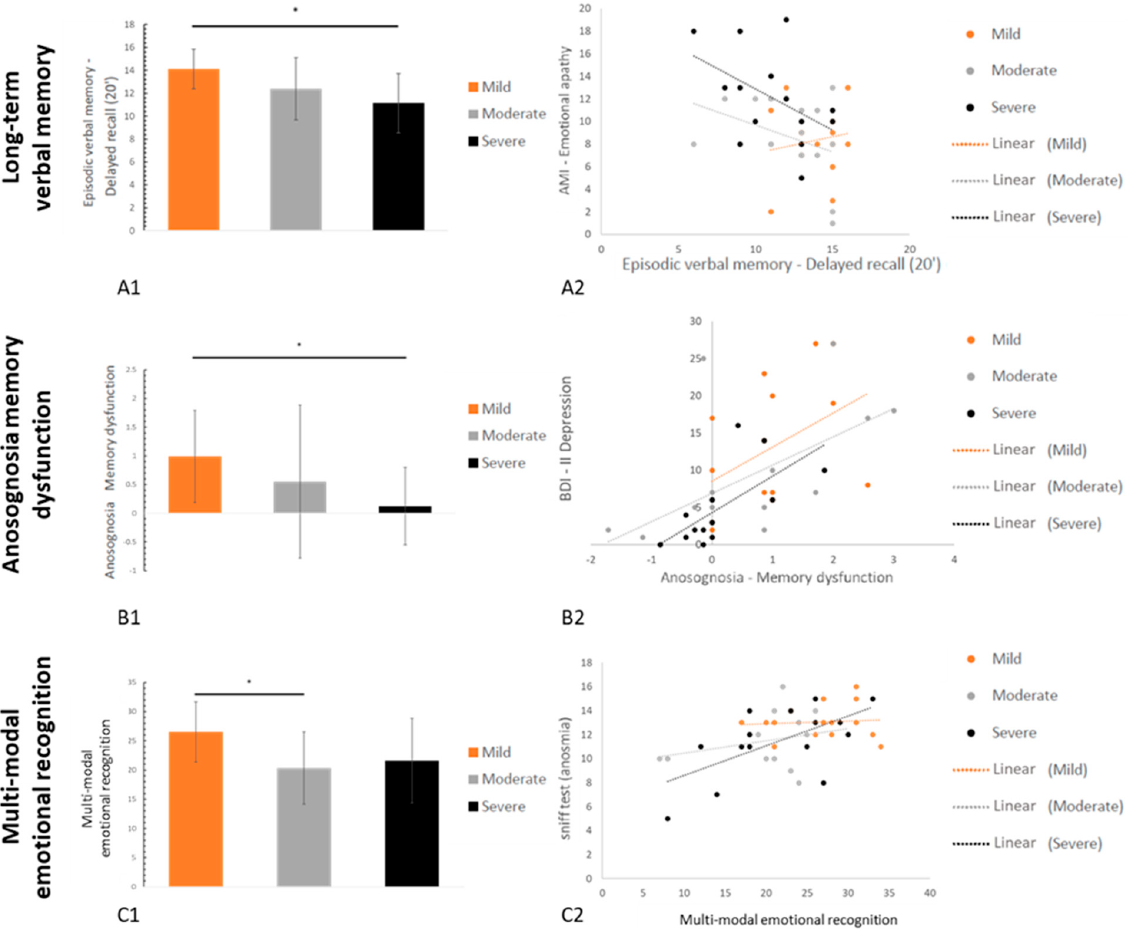
Figure 3 . Mean ratings (and standard deviations) for all three groups (severe [ICU hospitalization] in black, moderate [conventional hospitalization] in gray, and mild [no hospitalization] in orange) on tasks evaluating verbal episodic memory ( A1 ), anosognosia for memory dysfunction ( B1 ), and multimodal emotion recognition ( C1 ), as well as their respective predictors ( A2 , B2 , C2 ). Note. ( A2 ) The greater the emotional apathy, the poorer the performance on verbal memory (except for the mild group). ( B2 ) The lower the depression, the greater the anosognosia for memory dysfunction. ( C2 ) The poorer the olfactory recognition, the poorer the emotion recognition.